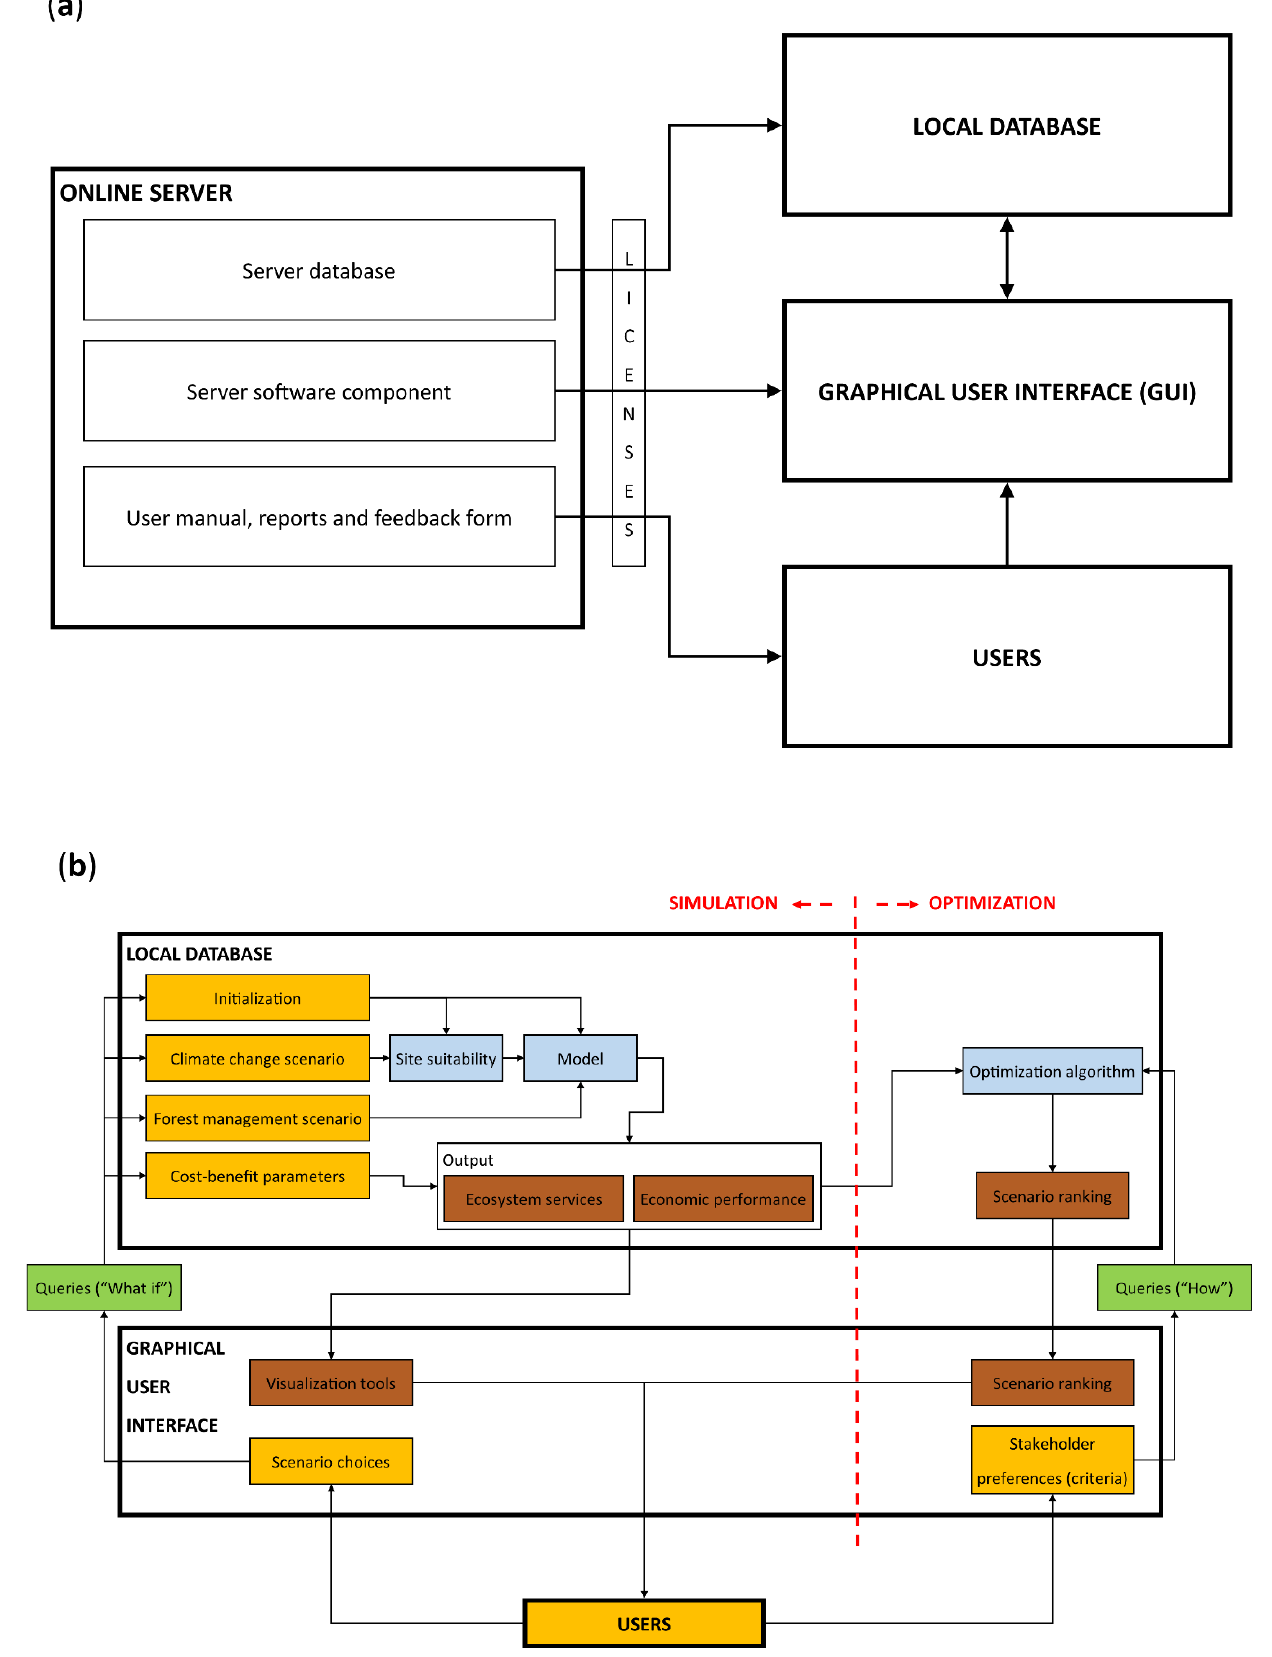
Figure 1. Sim4Tree components and workflow. ( a ) Communication between the server and the local components; ( b ) workflow of